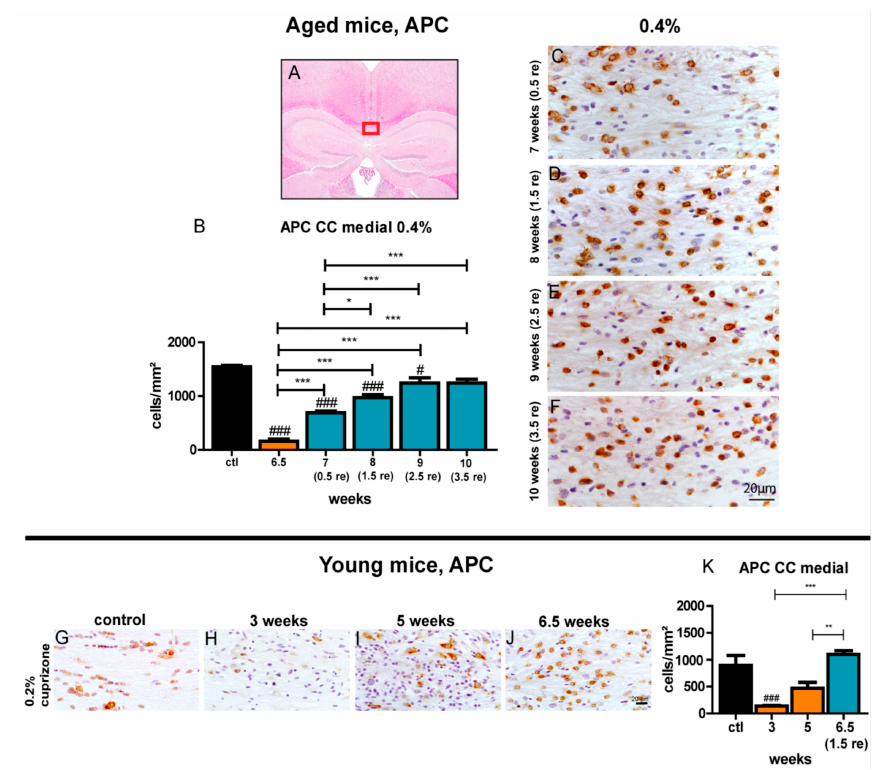
Figure 6. Repopulation of mature oligodendrocytes during remyelination in the medial corpus callosum of aged mice. The marked area (red box) in ( A ) shows the medial part of the corpus callosum that was investigated. Graphs display the number of APC-positive oligodendrocytes / mm 2 for the respective time points of demyelination and subsequent remyelination in aged mice fed for 6.5 weeks with 0.4% cuprizone ( B ) and young mice treated for 5 weeks with 0.2% cuprizone ( K ). See Figure 2 for representative sections of aged mice for control and demyelination after 0.4% cuprizone feeding for 6.5 weeks, respectively. Exemplary images show repopulation of APC-positive oligodendrocytes during the course of remyelination in the central corpus callosum of aged mice ( C – F ) and during de- and remyelination in young mice ( G – J ). Bars show mean + SEM. Significant e ff ects between di ff erent investigated time points are indicated by asterisks and e ff ects in comparison to control are indicated by hashmarks (* / # p < 0.05; ** / ## p < 0.01; *** / ### p < 0.001). Ctl. = control; 6.5 weeks = feeding